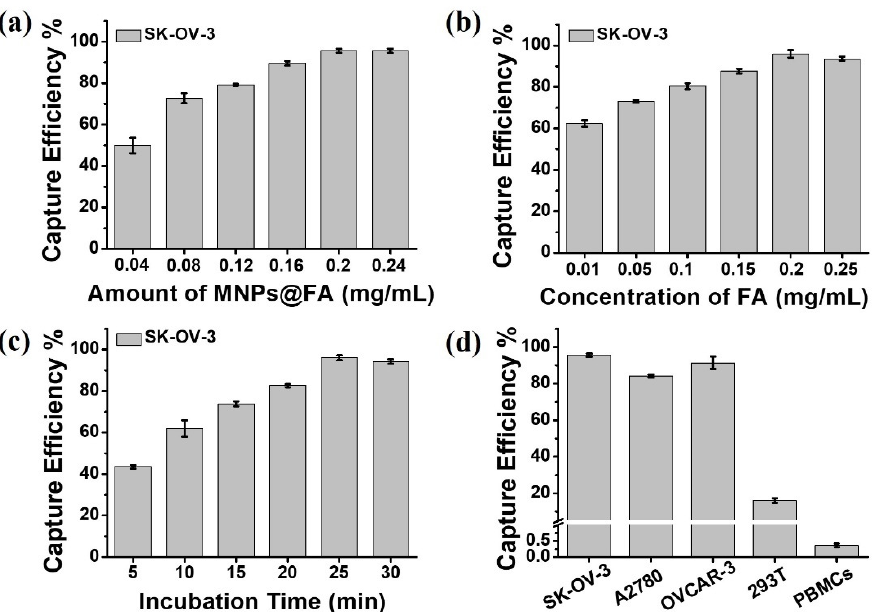
Figure 4. ( a ) Capture efficiency of MNPs@FA for SK-OV-3 cells at different concentrations (0.04, 0.08, 0.12, 0.16, 0.2, 0.24 mg/mL). ( b ) Capture efficiency of MNPs@FA for SK-OV-3 cells at the differ- ent modified concentrations of folic acid (0.01, 0.05, 0.1, 0.15, 0.2, 0.25 mg/mL). ( c ) Capture efficiency of MNPs@FA for SK-OV-3 cells at different incubation times (5, 10, 15, 20, 25, 30 min). ( d ) Capture efficiencies of MNPs@FA for different cells. All data are expressed as the mean ± stand deviation, n = 3.